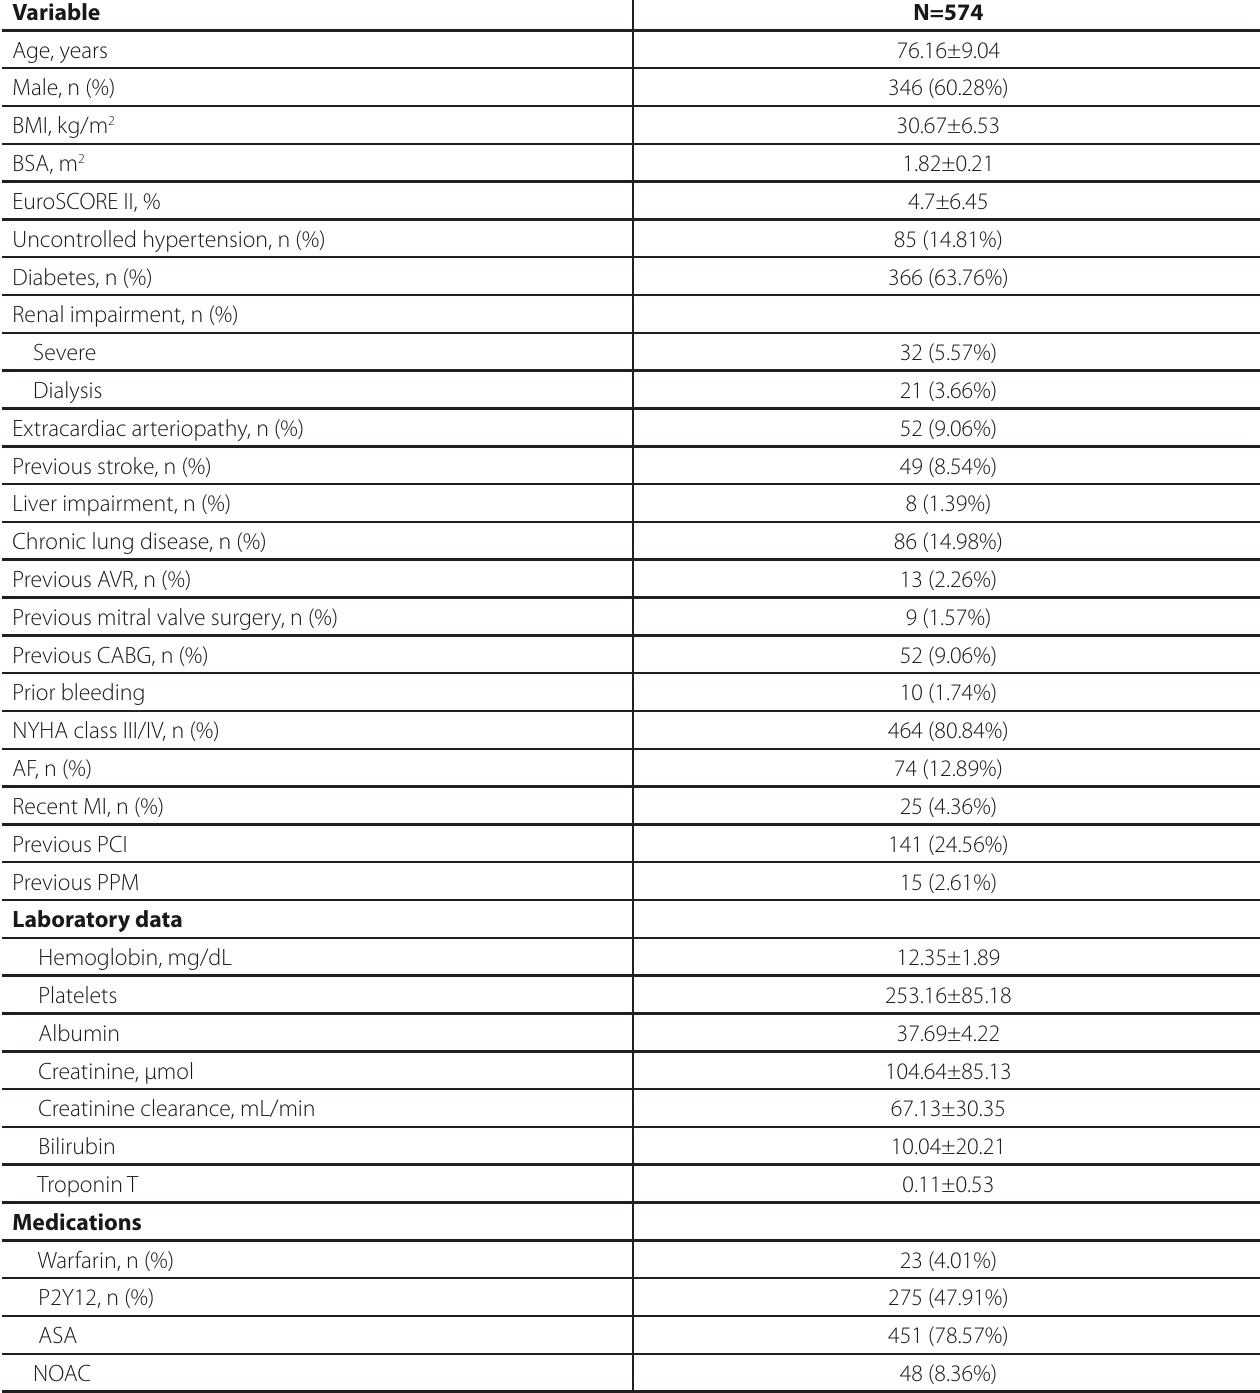
Table 1. Patients’ perioperative